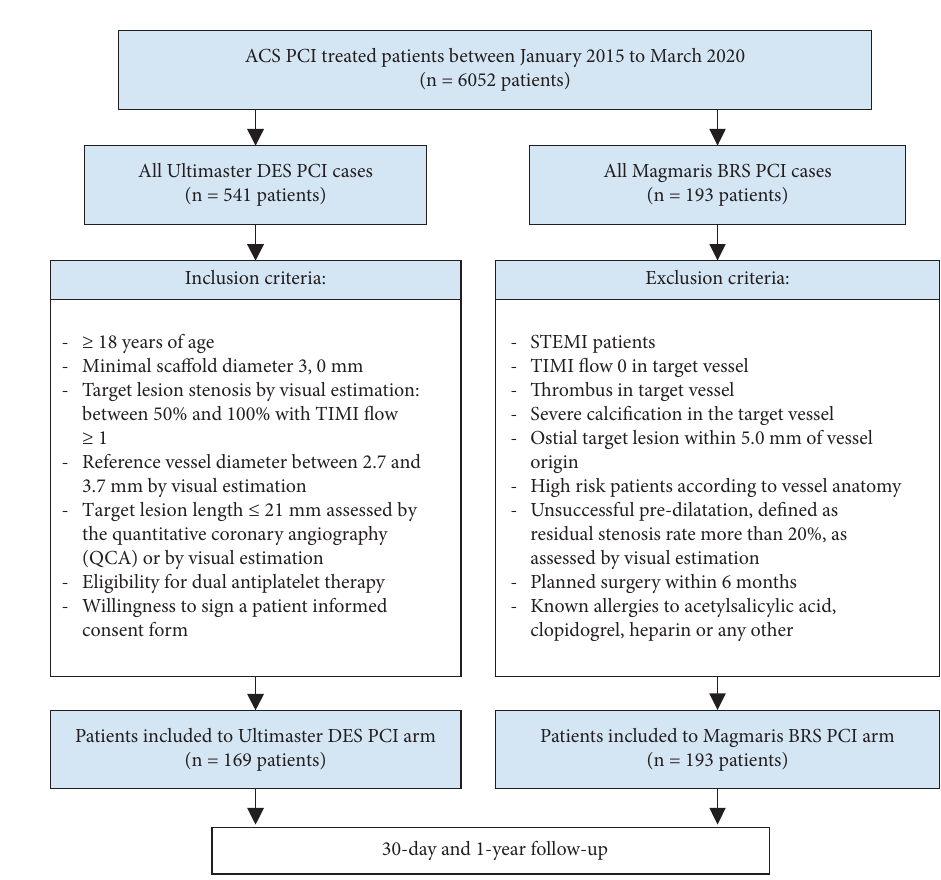
Figure 1: Study fow diagram with inclusion and exclusion criteria.